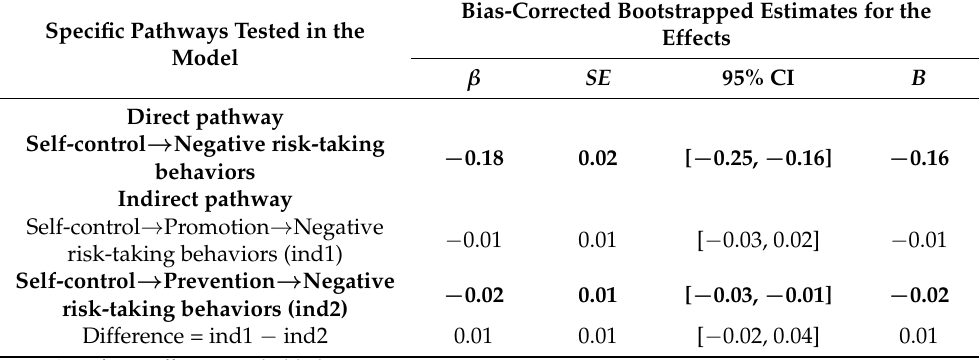
Table 2. The specific indirect effect for each indirect pathway in the mediation model based on the bias-corrected bootstrapped estimates.